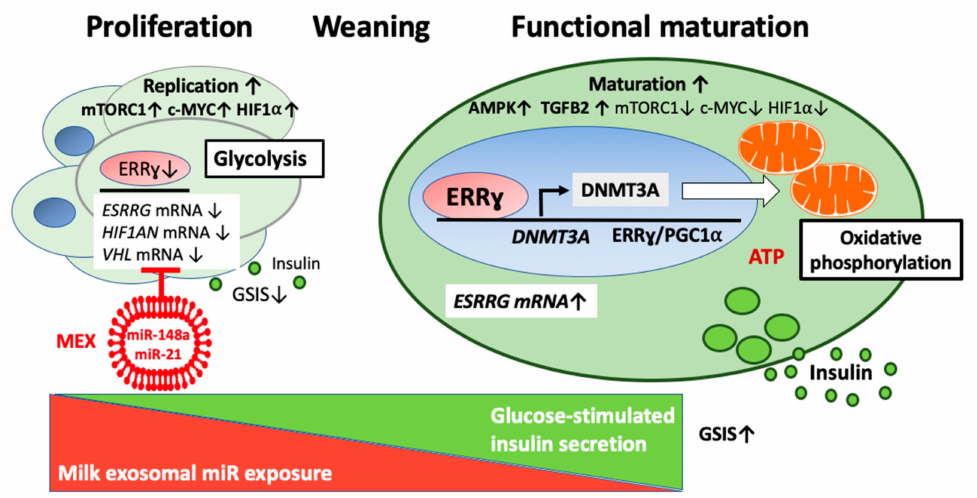
Figure 6. Predicted model of milk exosome (MEX) miR-mediated suppression of estrogen-related receptor γ (ERR γ ). MiR-148a targets ESRRG mRNA and thus impairs ERR γ expression, a negative regulator of glycolysis. MiR-148a and miR-21 promote glycolysis via targeting hypoxia-inducible factor 1 α inhibitor ( HIF1AN ) and von Hippel-Lindau tumor suppressor ( VHL ), respectively. Both are key negative regulators of hypoxia-inducible factor 1 α (HIF-1 α ), the key transcription factor of glycolysis, which is required for cell proliferation. Functional maturation of β cells after weaning is associated with fading MEX miR signaling, enhancing the expression of ERR γ , the key transcription factor of mitochondrial oxidative phosphorylation. ERR γ may also promote the expression of DNA methyltransferase 3A ( DNMT3A ), which, via promoter methylation, may suppress “disallowed genes” involved in glycolysis. ERR γ /DNMT3A signaling may stimulate insulin secretion coupled to glucose